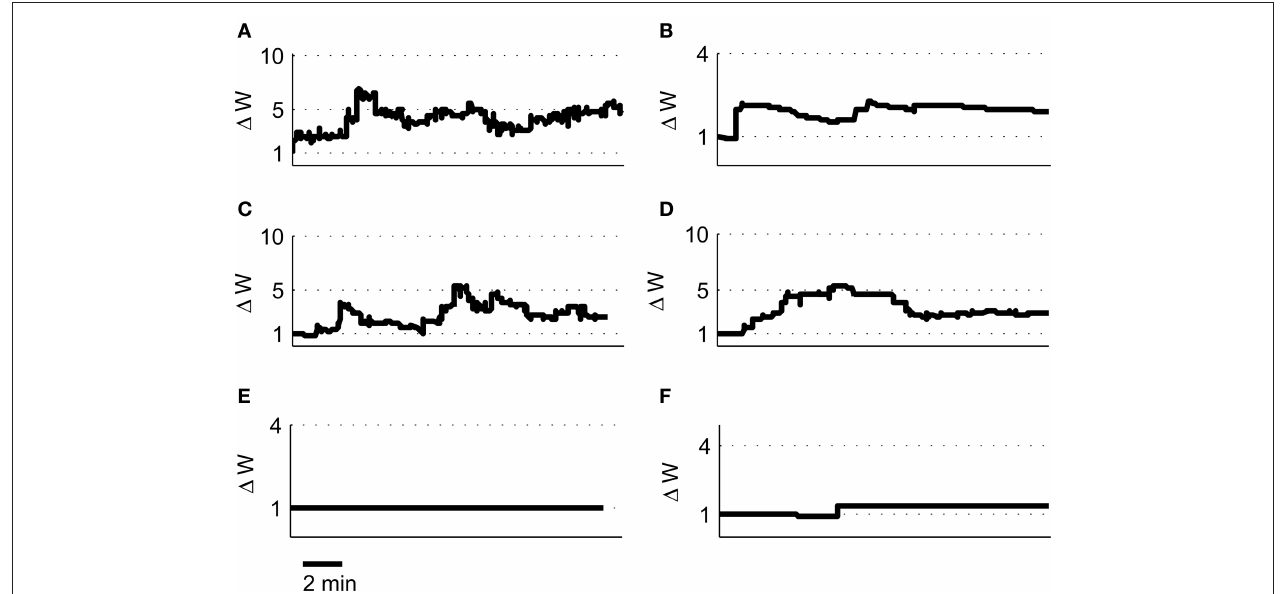
Figure 9 | Predicted synaptic weight changes for overlapping and non-overlapping place cell activity. Calculated synaptic weight changes for four pairs of overlapping place cells 2